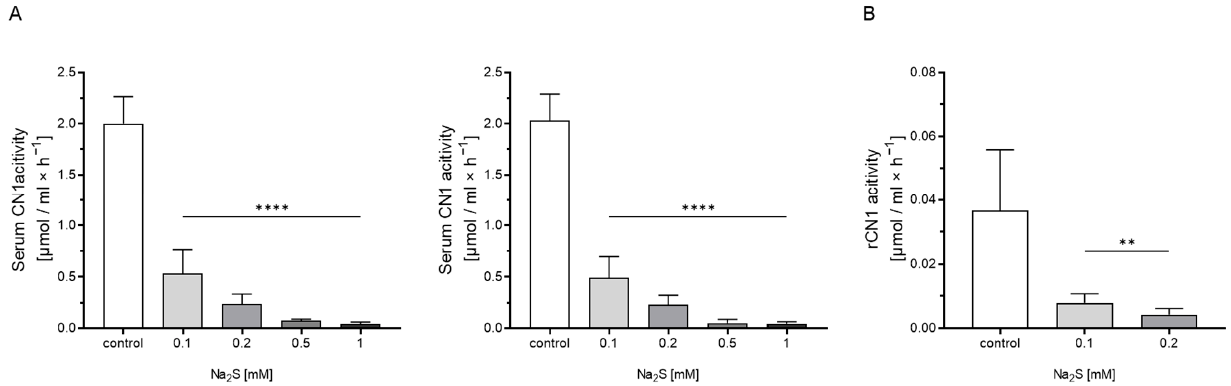
Figure 2. Effect of H 2 S on human serum CN1 activity and on recombinant CN1 activity (rCN1). ( A ) Addition of H 2 S donor sodium disulfide (Na 2 S) reduced human serum CN1 activity dose-dependently for carnosine (left panel) and anserine (right panel) as the substrate. ( B ) Degradation rate for carnosine was also reduced by Na 2 S for the recombinant carnosinase 1 (rCN1). **: p < 0.01; ****: p < 0.0001 (one-way ANOVA with Tukey’s test).